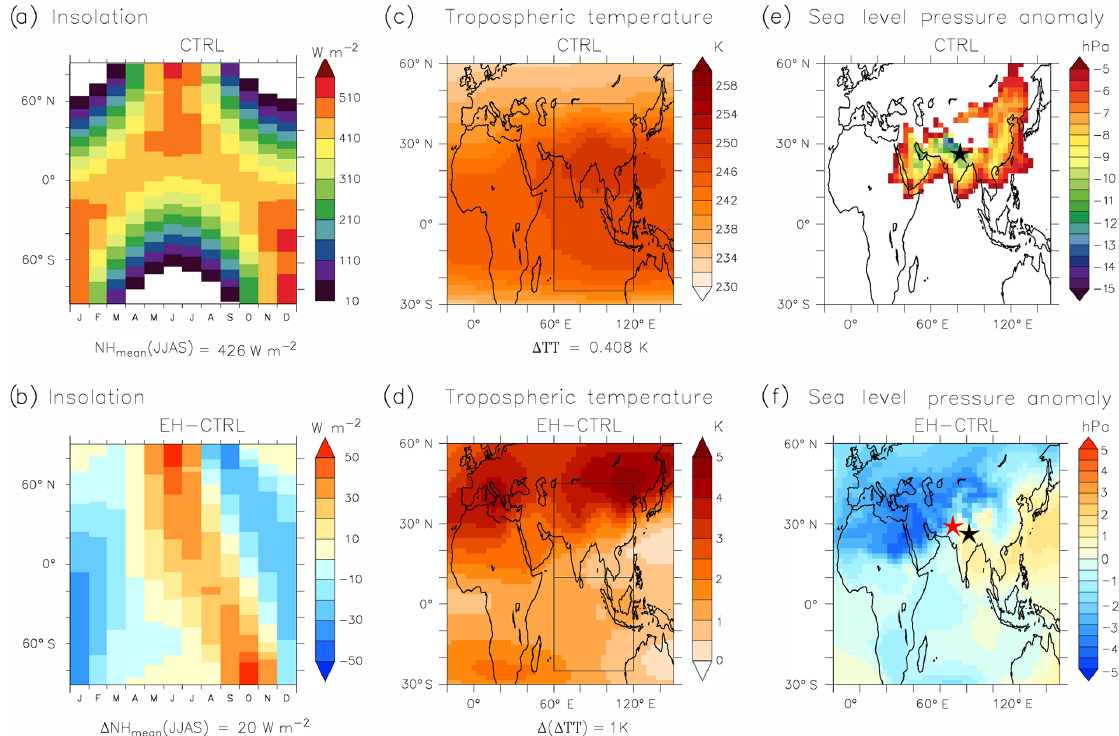
Figure 5. (a, b) Seasonal cycle of the insolation at the top of the atmosphere (Wm − 2 ) in (a) the CTRL simulation and (b) the difference between EH and CTRL. The Northern Hemisphere (0–90 ◦ N) mean summer (JJAS) insolation, NH mean (JJAS), in CTRL and the difference between the EH and CTRL simulations, (cid:49) NH mean (JJAS), is given under panels (a, b) , respectively. (c, d) Upper-tropospheric temperature (TT) averaged between 200 and 500hPa in (c) the CTRL simulation and (d) the difference between EH and CTRL. (cid:49) TT value, under panel (c) , is the TT gradient between a northern region (60–120 ◦ E, 10–45 ◦ N) and a southern region (60–120 ◦ E, 25 ◦ S–10 ◦ N) (black boxes on the maps). (cid:49) ( (cid:49) TT), under panel (d) , is the difference of TT gradients between EH and CTRL. (e, f) Boreal summer (JJAS) sea level pressure (SLP) anomaly (from the annual mean) lower than − 5hPa for (e) the CTRL simulation and (f) the difference between the EH and CTRL. The SLPa-5 barycentre (i.e. barycentre of the SLP anomalies lower than − 5hPa over the region 20 ◦ W–150 ◦ E, 30 ◦ S–60 ◦ N) is represented by a black star for CTRL in (e, f) and by a red star for EH in (f)